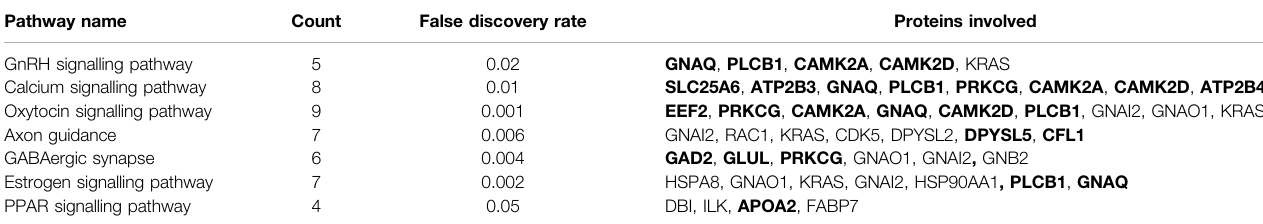
TABLE 2 | Enriched pathways related to differentially abundant proteins in heifer puberty in the